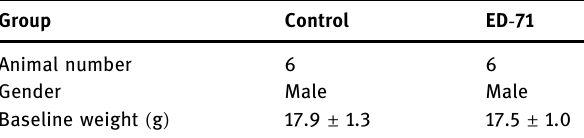
Table 1: Information of animal